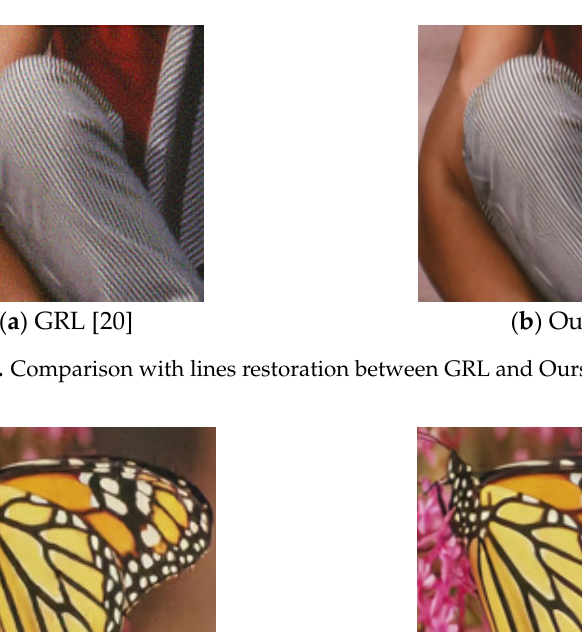
Figure 8. Comparison with lines restoration between GRL and Ours.